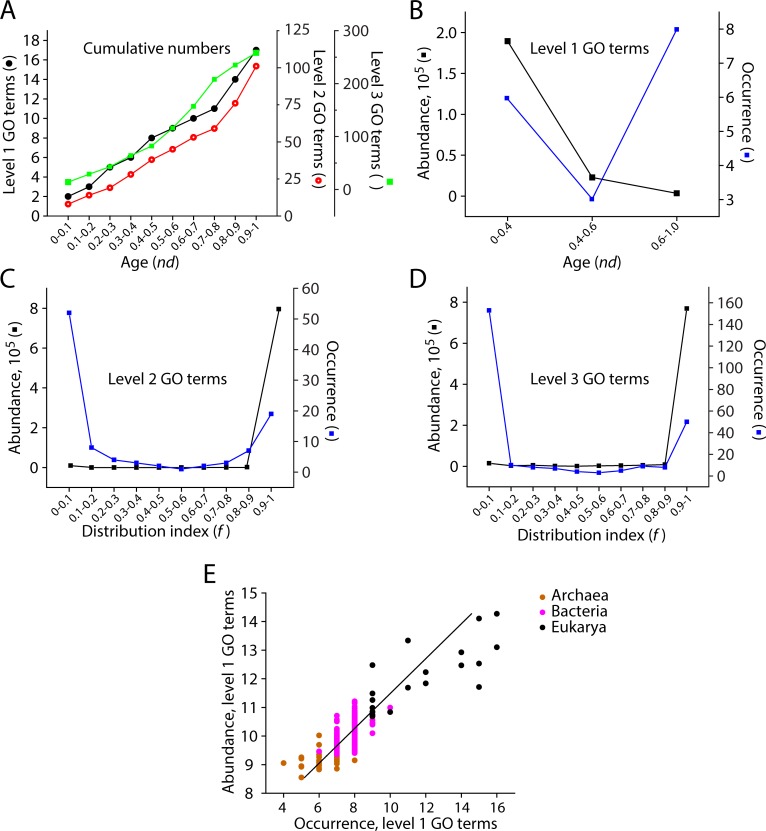
Relationship between abundance and occurrence.(A) Accumulation of level 1, level 2 and level 3 molecular functions along the evolutionary timeline. (B) Plot of abundance and occurence for level 1 GO terms against their age (nd) describes diversity of level 1 of DAGmf. (C) Plot of abundance and occurence for level 2 GO terms against their age (nd). (D) Plot of abundance and occurence for level 3 GO terms against their age (nd). (E) Functional diversity (occurence) plotted against the abundance of level 1 GO terms for 249 proteomes. The three superkingdoms are colored. Abundance values are provided in log2 scale.